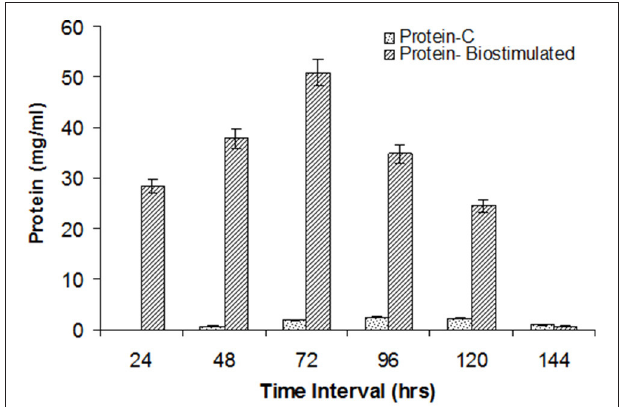
FIGURE 3 | Pattern of protein during pulp and paper mill effluent decolourisation after biostimulation of autochthonus bacteria by 2% glucose and 0.5% peptone.